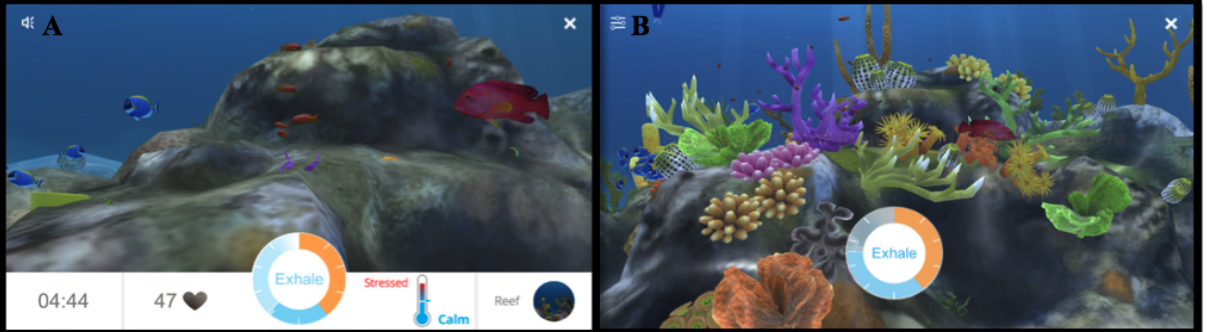
Figure 2. Example of how the full display unfolds when an individual is using